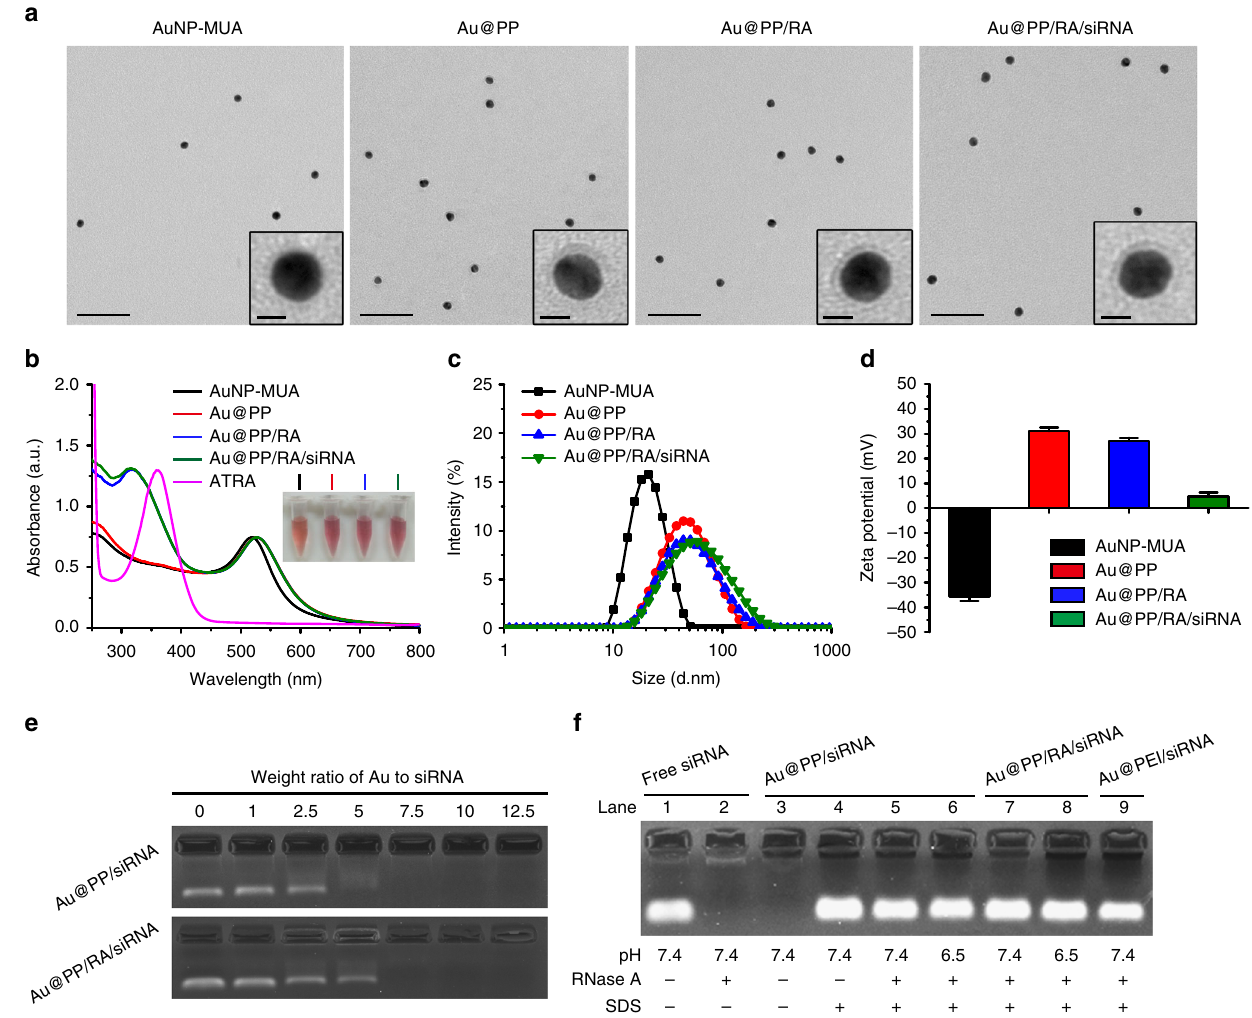
Fig. 2 Characterisation of the Au@PP/RA/siRNA nanosystem. a Representative TEM images of AuNP-based nanosystems. Scale bars, 100 nm. Insets, enlarged micrographs. Scale bars, 10 nm. b UV – vis absorbance spectra of the indicated nanosystems and ATRA. Insets, photographs of the indicated nanosystem samples. c Size distribution of the nanosystems measured by dynamic light scattering (DLS). d Zeta potential of the nanosystems in 10 mM HEPES buffer (pH 7.4). The data are shown as the mean ± s.d. ( n = 3). e Agarose gel electrophoresis retardation assay of siRNA at various w/w ratios of Au to siRNA. Complete retardation of siRNA was achieved at the w/w ratio of 7.5 for both nanosystems. f siRNA protection assay of different nanosystems treated with RNase A for 2 h at pH 7.4 or 6.5. Compared to the untreated lane 4 (Au@PP/siRNA without RNase A treatment, set as 100%), the remaining siRNA amounts were 81%, 77%, 84%, 77 and 60% for lanes 5 – 9, respectively, after RNase A